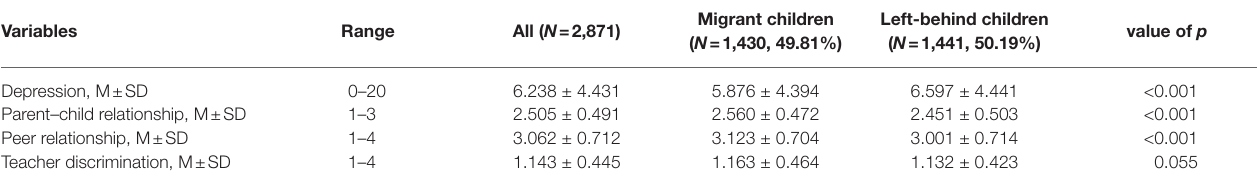
TABLE 2 | Descriptive statistics of key variables of migrant and left-behind children. Variables